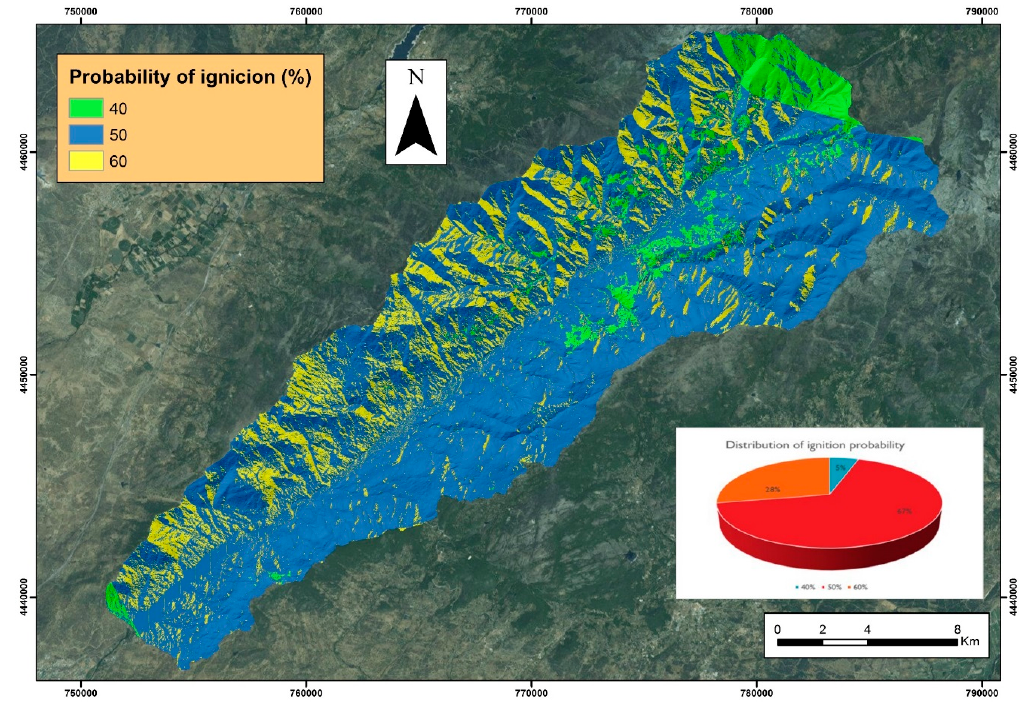
Figure 12. Probability of ignition mapping.